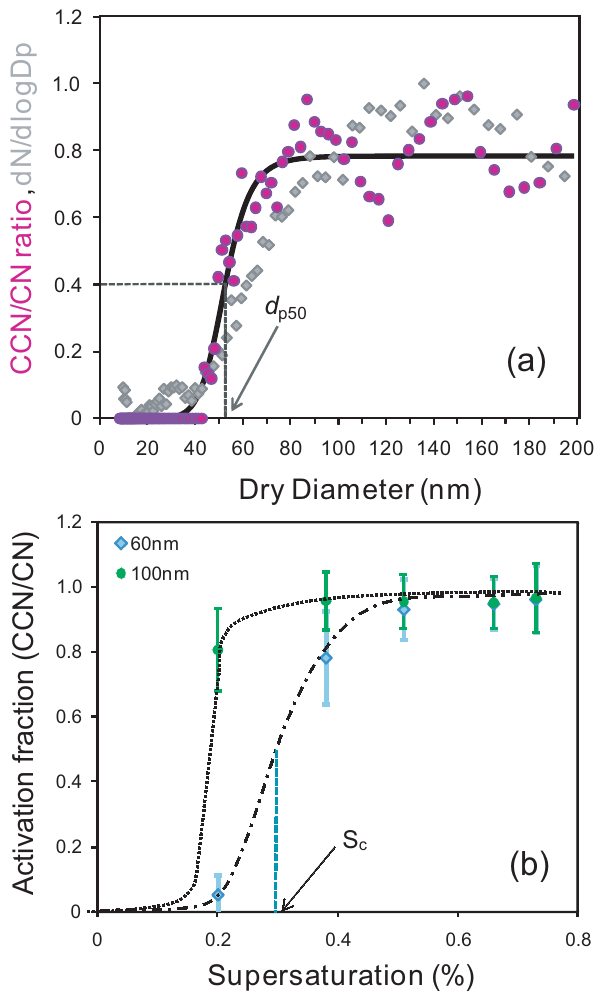
Fig. 3. (a) CCN activation fraction and distribution from 25 July at 11:49a.m. (UTC+2) with sigmoidal fit at 0.3% supersaturation and (b) example of CCN activity spectrum from 3 August (00:12– 11:58a.m. (UTC+2)) for 60 and 100nm